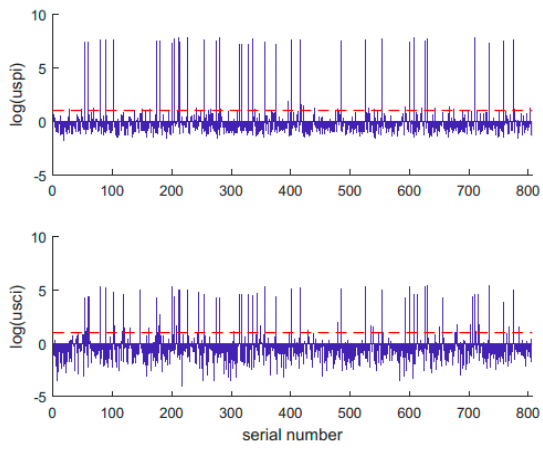
Figure 8. Values of unhealthy satellite positioning index (uspi) and unhealthy satellite clock index (usci) corresponding to unhealthy states that lasted for less than one hour.